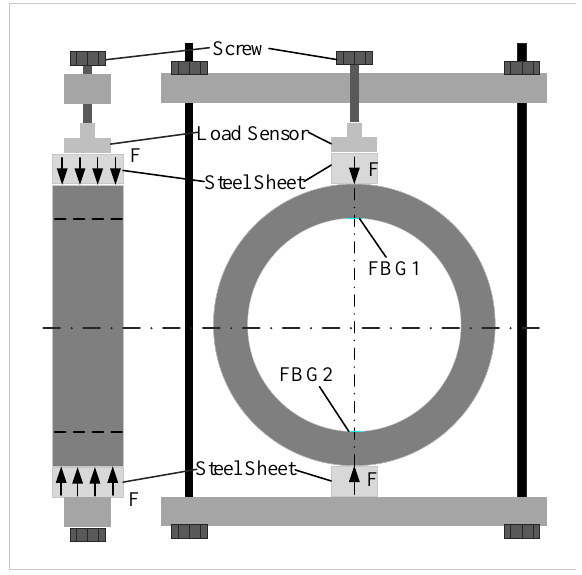
Figure 6. Diagram of pressure